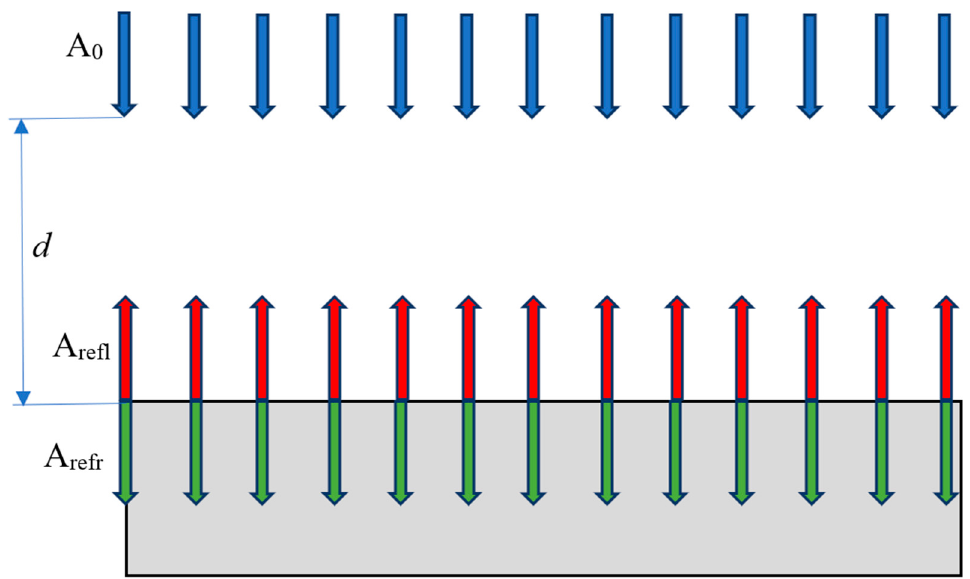
Figure 6. Changes in the parameters of the impact of the primary impulse of force when falling on a rectangular object.